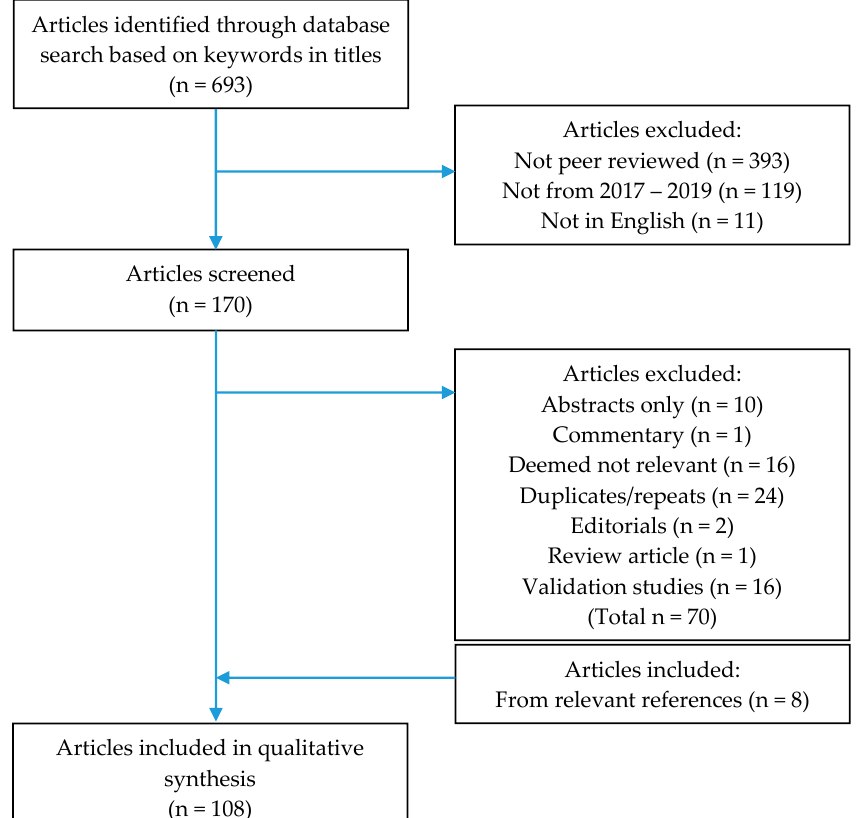
Figure 1. Process of final article selection for the current review.